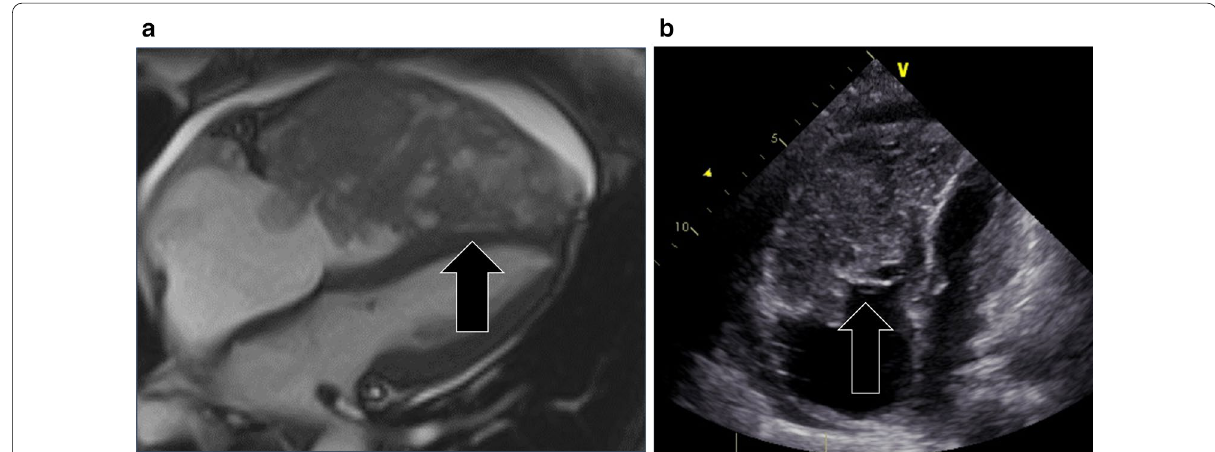
Fig. 4 Image at last follow-up. Magnetic resonance imaging ( a ) and echocardiography ( b ) confirm a massive metastasis in the right ventricle